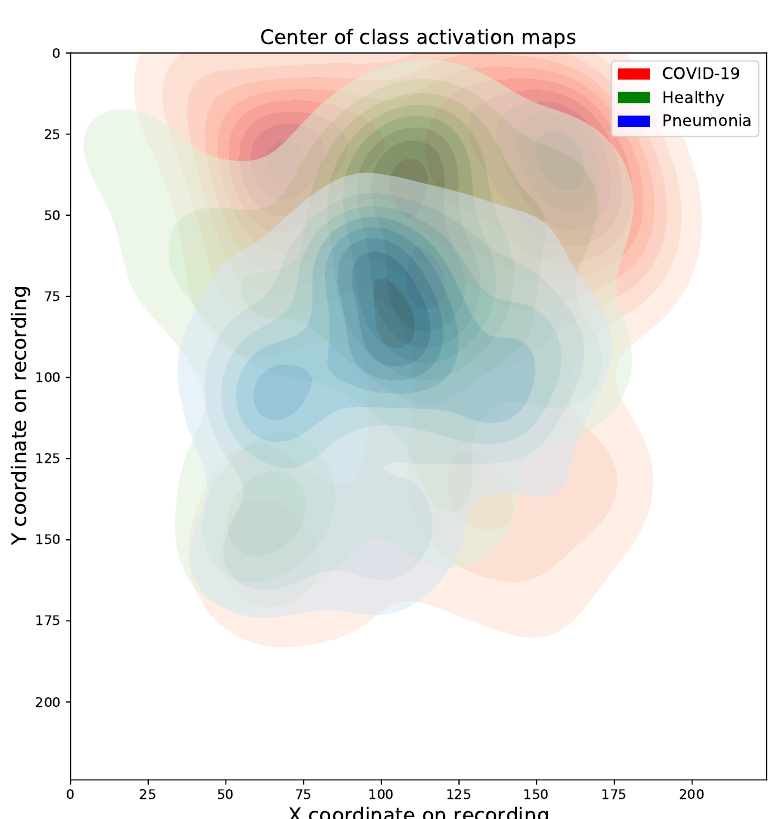
Figure A4. Density plot of centers of class maps. Pneumonia-CAMs are rather centralized compared to other CAMs. Problematically, COVID-CAMs seem to exhibit a tendency for upper regions of the probe that do not necessarily belong to the